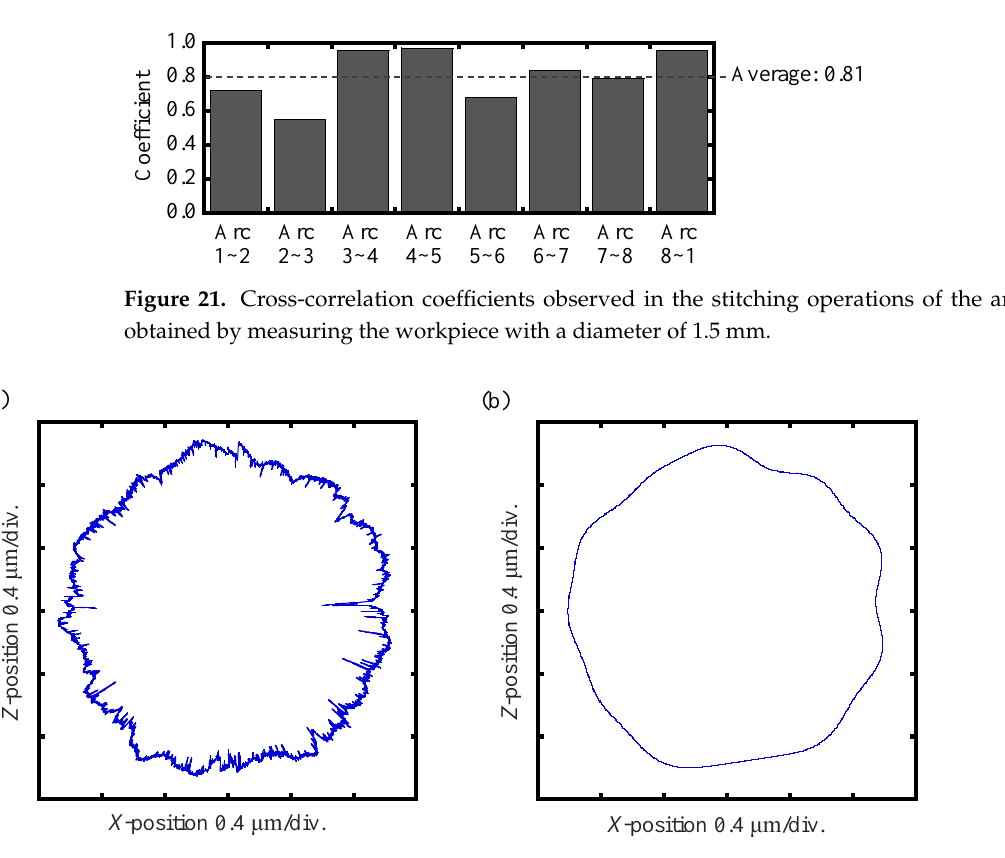
Figure 22. The circumferential profile of the workpiece obtained through the stitching operation: ( a ) Before the filtering process; ( b ) After the filtering process. Table 2. The diameter and out-of-roundness of the workpiece evaluated from the circumferential profile obtained by the stitching linear-scan method.